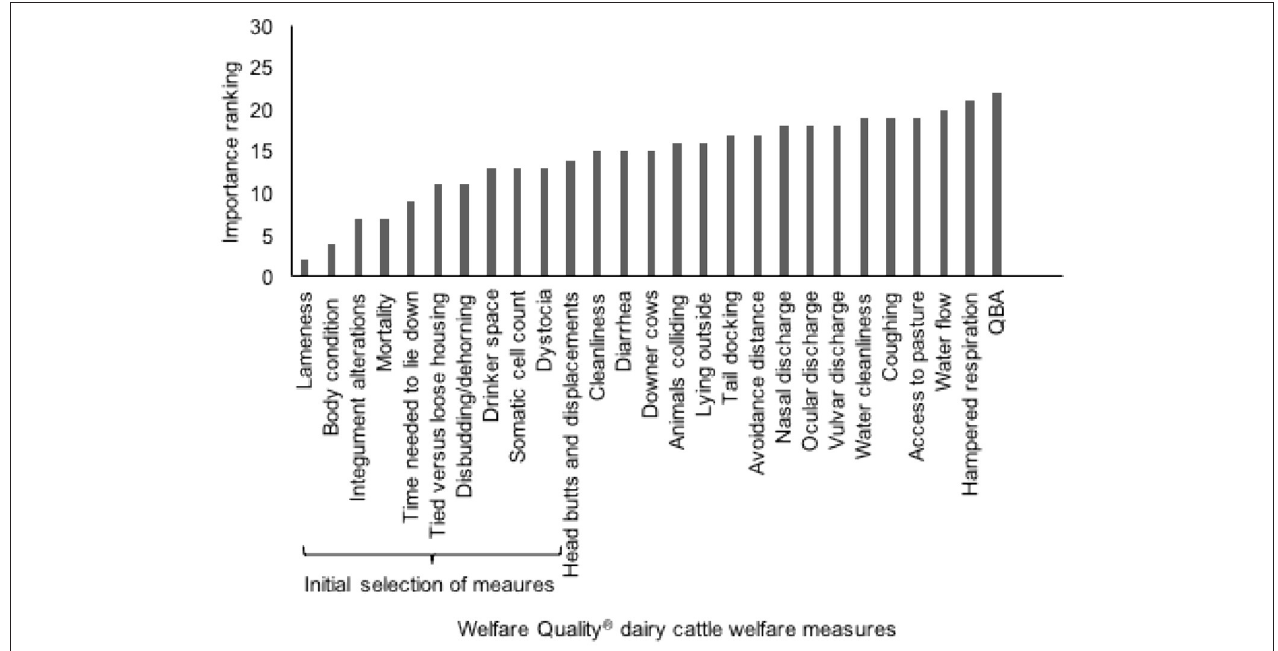
FIGURE 3 | Median importance ranking for all WQ measures as judged by 16 dairy cattle welfare experts. Initial selection of 10 welfare measures for the WI indicated using